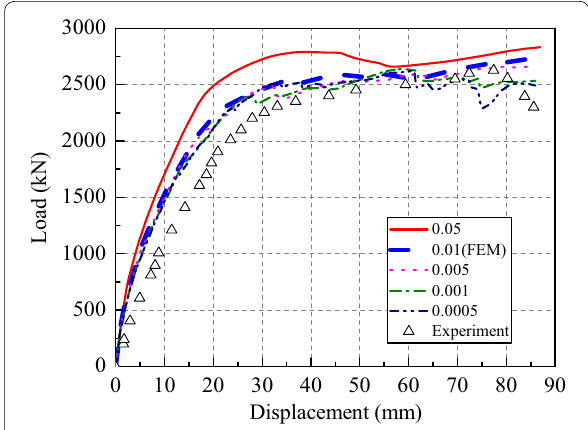
Fig. 25 Effect of the viscosity parameter.